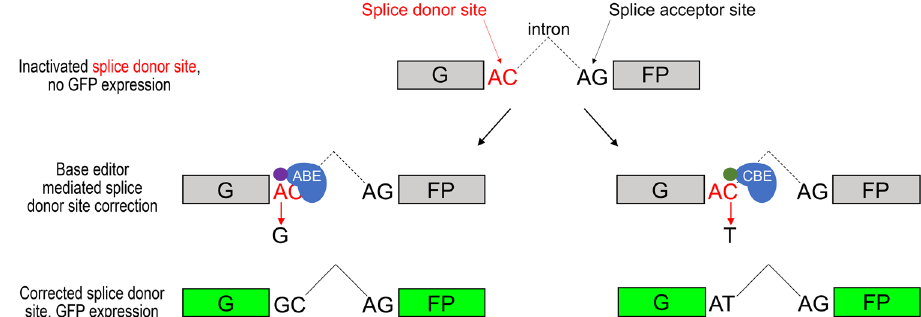
Fig. 1 Principle of the base editor activity reporter (BEAR) assay. BEAR consists of a split GFP coding sequence (green) separated by an intron of which splice donor site is altered to ‘ AC ’ , resulting in a dysfunctional protein (grey). This inactive splice donor site can be rescued either by ABEs reverting the ‘ AC ’ splice donor site to ‘ AT ’ or by CBEs reverting the ‘ AC ’ splice donor site to ‘ GC ’ , respectively. ‘ AT ’ and ‘ GC ’ are known to be functional non-canonical splice donor sites in the human genome.